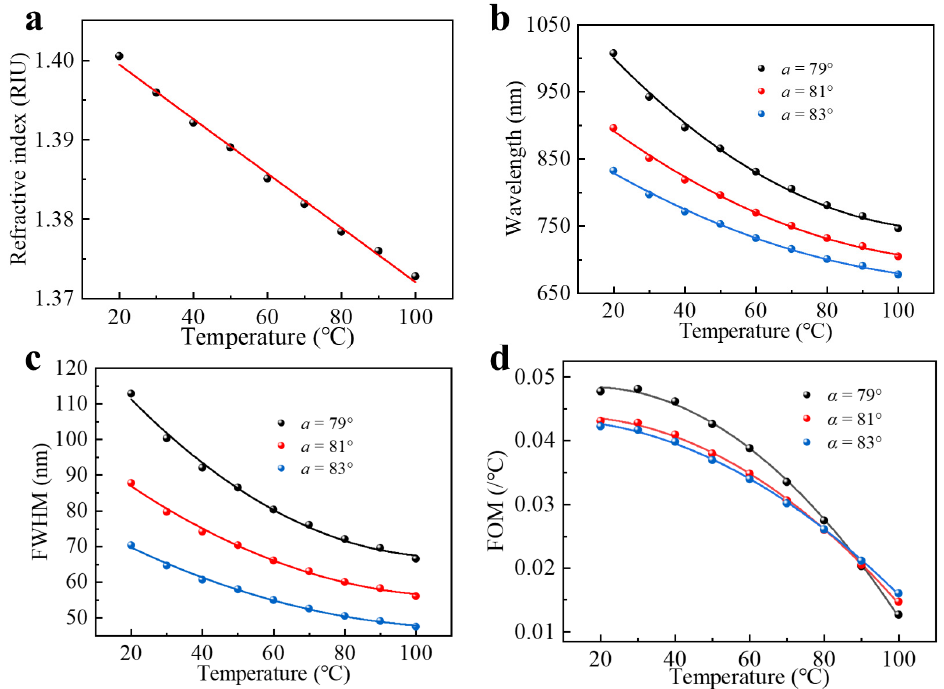
Figure 2. ( a ) Variation of RI of n-butanol with temperature. ( b ) Simulated SPR wavelengths. ( c ) Spectral FWHM and ( d ) spectral FOM as a function of temperature under different fiber polishing angles. The nonlinear fitting curves are to guide the eyes.